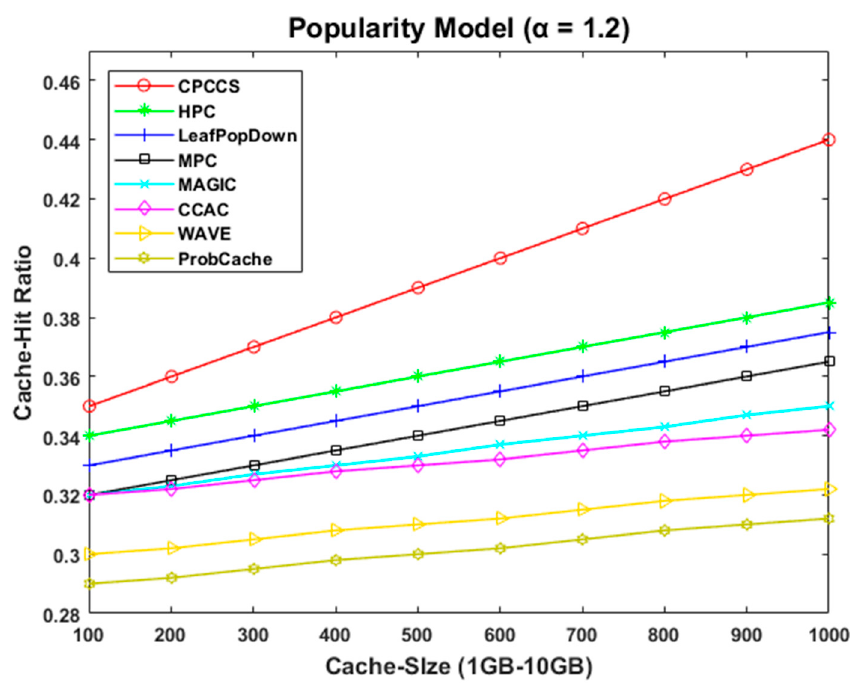
Figure 2. Cache hit ratio with user generated content (UGC) .